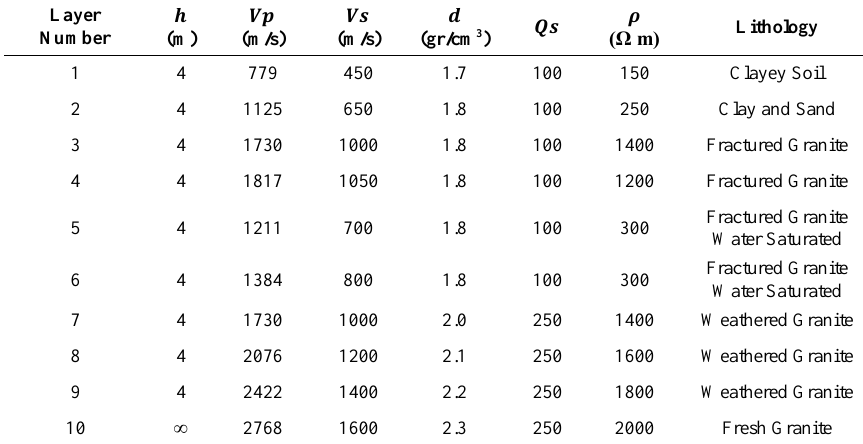
Table 2. Model of hard rock environment. The layered resistivity model is prepared based on the observations in Kumar et al. (2016) [61]. The shear-wave velocities – 𝑽𝒔 are adopted from Keçeli (2012) [62]. The compressional-wave quality factor set to 𝑸𝒑 = 𝟐𝑸𝒔